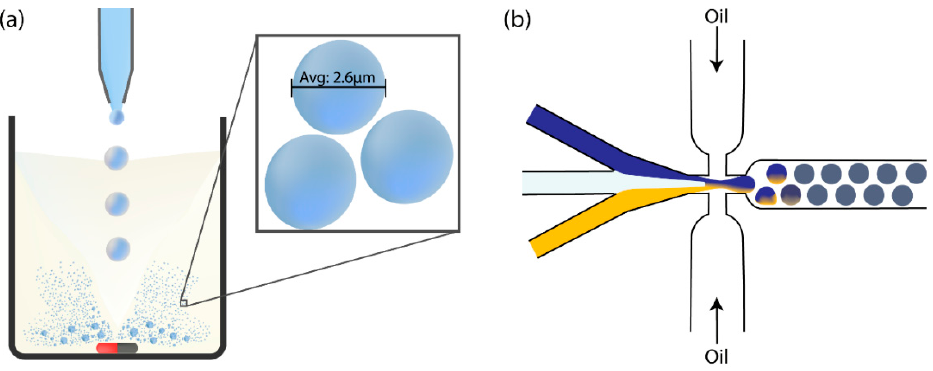
Figure 2. Methods of emulsion generation. ( a ) Emulsion generation using a stirrer to break the introduced aqueous phase into droplets within an oil medium; with an average reported droplet diameter of 2.6 µm [33]; ( b ) Using PDMS-based microfluidics, different reagents (Blue and Yellow) are mixed at the focal point of a mixed junction. Oil flowing in parallel interrupts the flow of reagents, which splits the stream into monodisperse droplets.